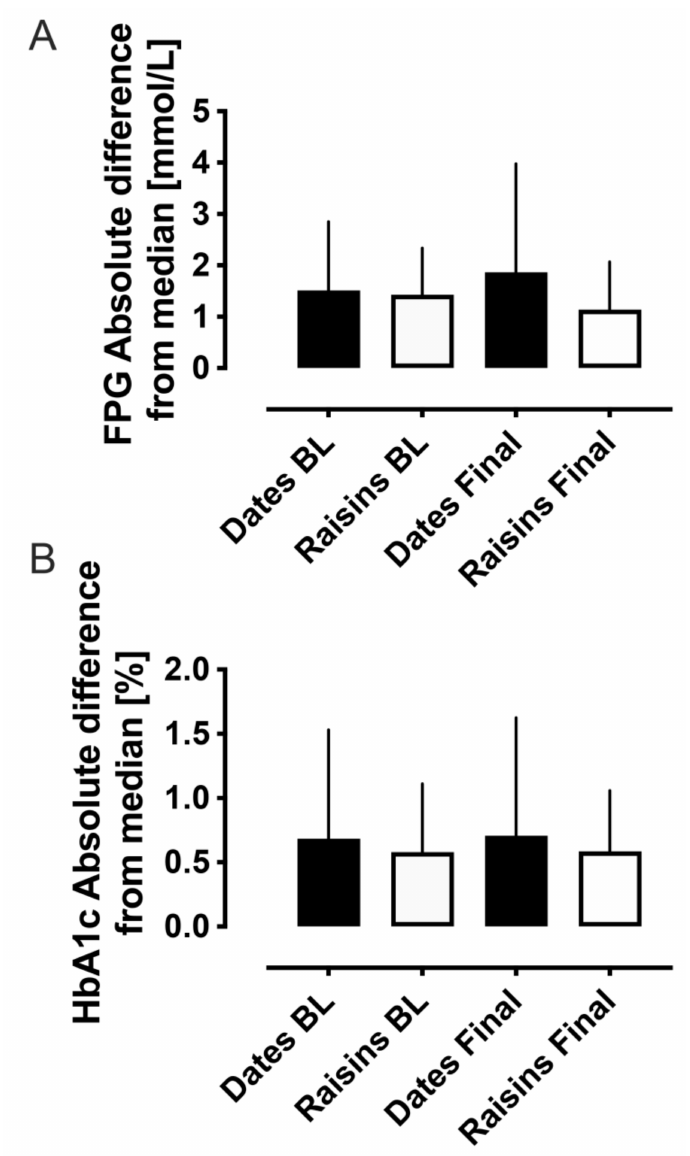
Figure 3. The absolute difference from the median for FPG ( A ) and HbA1c ( B ), indicating no difference in variability either between or within groups for either the date fruit or raisins. BL,